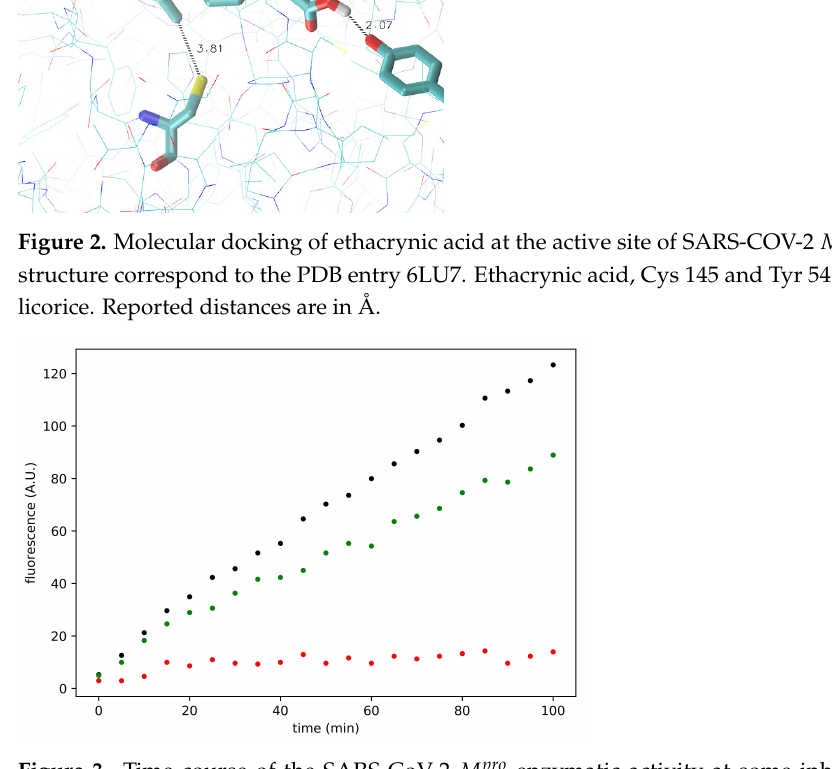
Figure 3. Time course of the SARS-CoV-2 M pro enzymatic activity at some inhibitor concentra- tions. Black, green and red dots represent positive control, 3.125 µ M and 100 µ M ethacrynic acid, respectively. Reported traces are the average of three